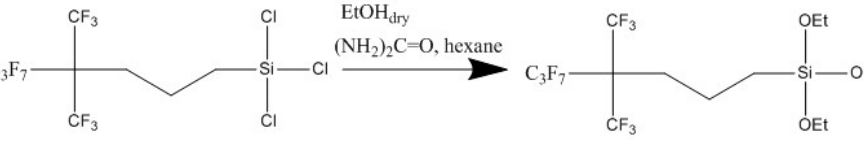
Figure 1. Trichlorosilane addition reaction scheme.